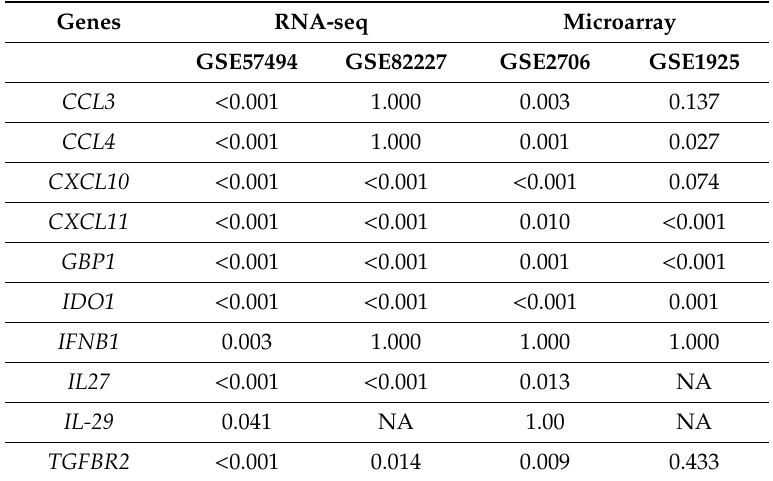
Table 2. p -value table from di ff erential gene expression tests between unstimulated versus stimulated myeloid cells in RNA-seq and microarray datasets. Genes